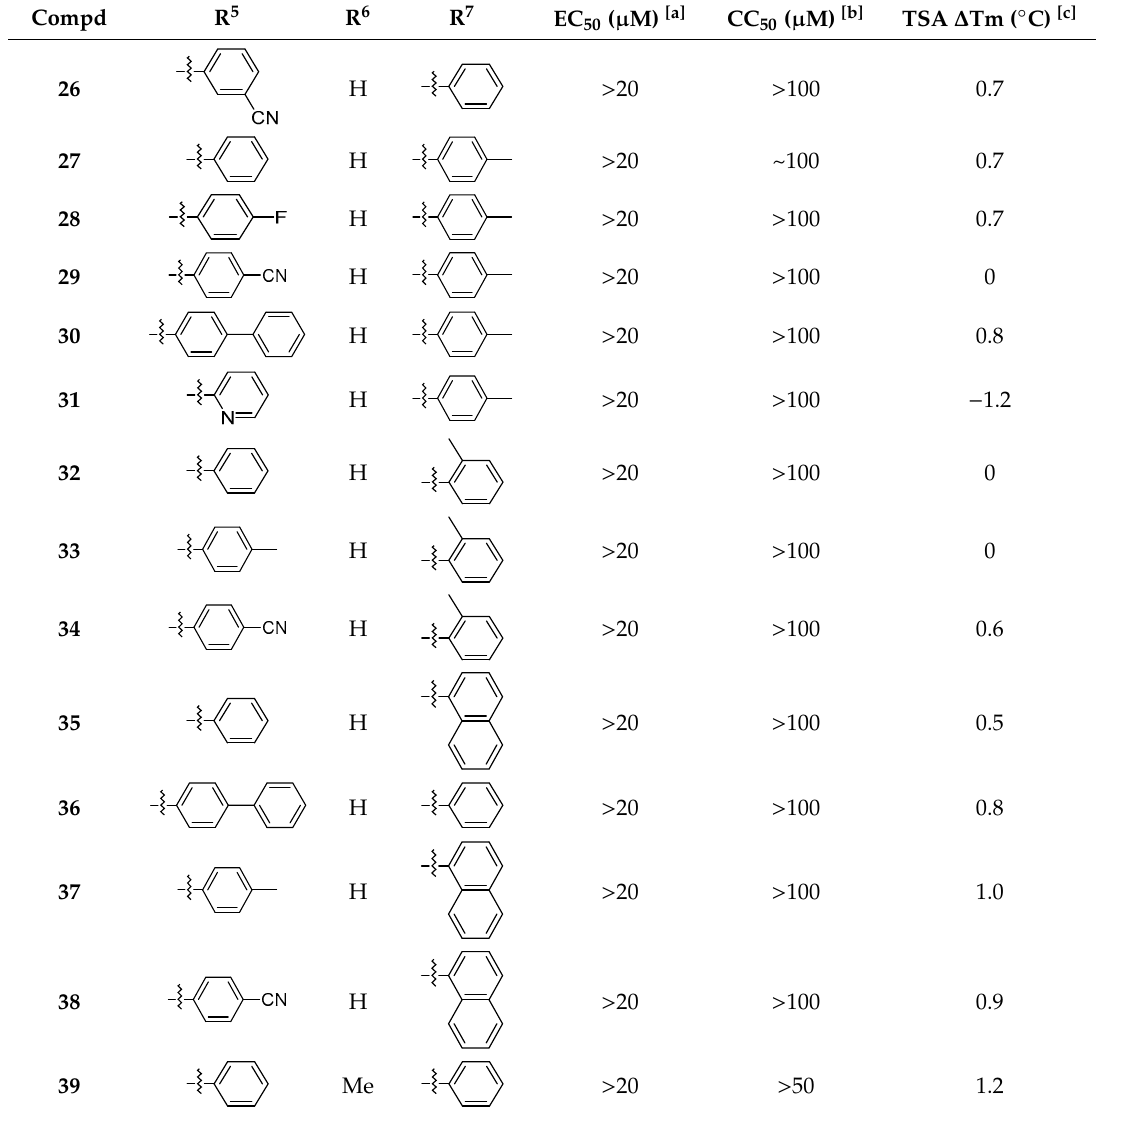
Table 3. Anti-HIV-1 activity, cytotoxicity, and CA hexamer stability profiles of 22–39 (R 5 , R 6 , and R 7 ).